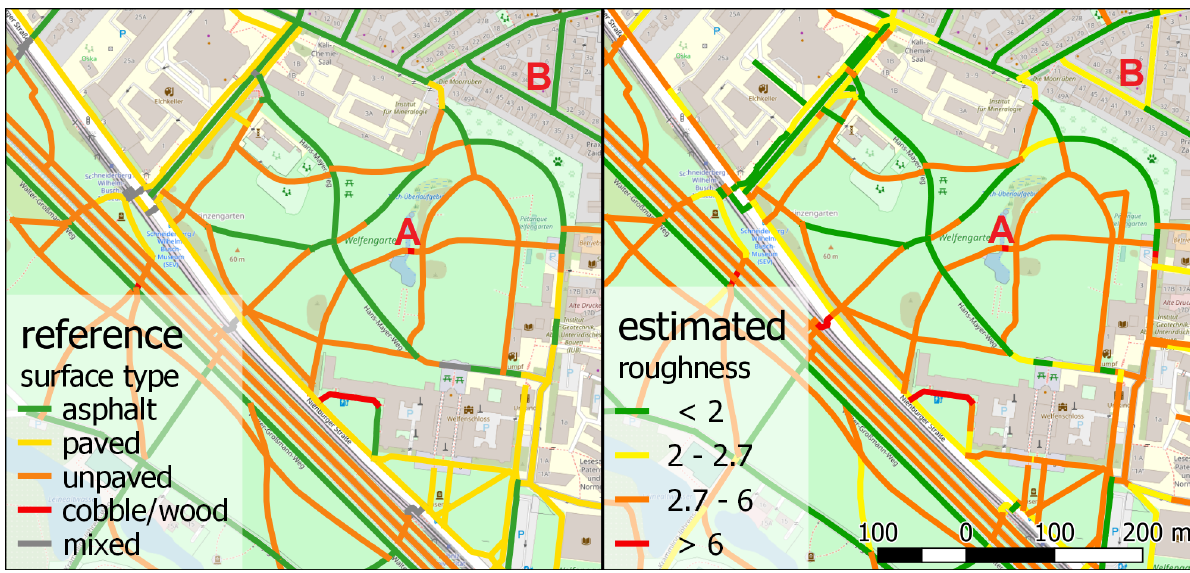
Figure 6. To give an example of the results, way segments in and around the university park are colored by their surface type (left) and by the estimated roughness value (right). They are ordered by smoothness and colored from green (asphalt - smooth) to red (cobblestone/wood planks - rough). For an easy comparison the estimated roughness values are also grouped into four related classes. (base map and data from OpenStreetMap)